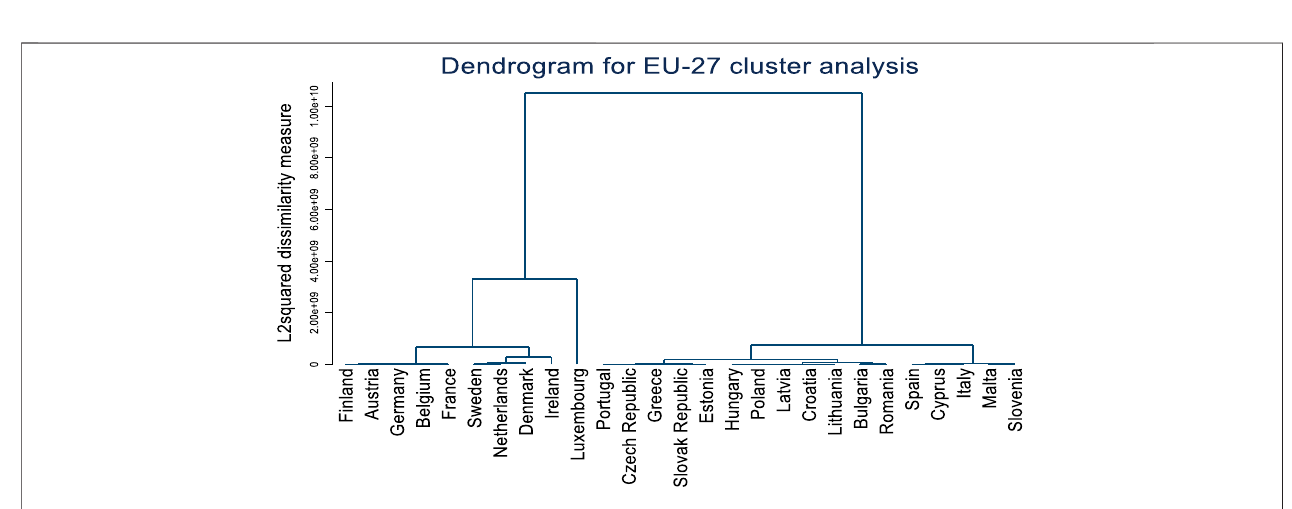
FIGURE 5 | | Dendrogram of cluster analysis, EU-27, 2018. Source: Authors ’ contribution.